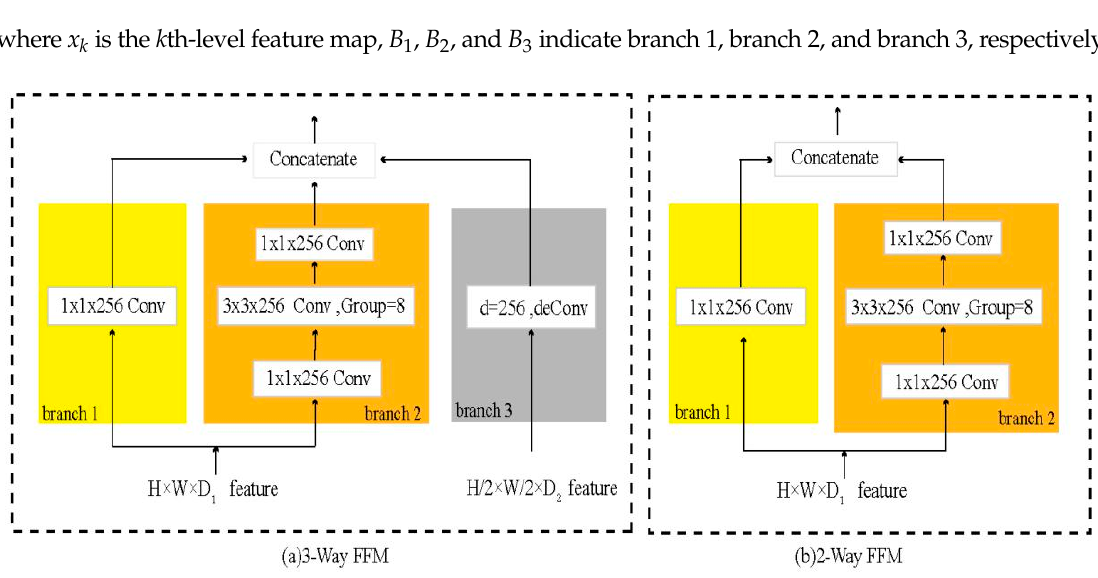
Figure 2. Feature Fusion Module, in which each conv box denotes a Conv + BN + ReLu processing. ( a ) 3-Way FFM is inserted in the Conv4_3, FC7, Conv6_2, Conv7_2, and Conv8_2 of the feature pyramid structure and ( b ) 2-Way FFM is inserted in the Conv9_2.